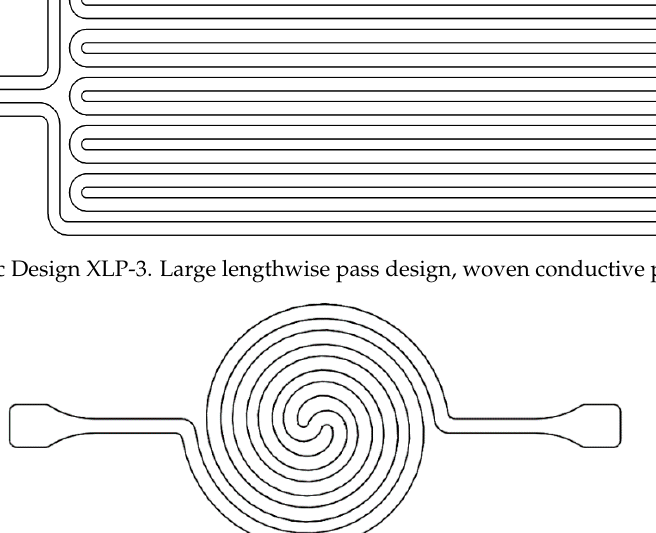
Figure A15. Spiral Fabric Design SS-5. Single spiral design, polyester tape.